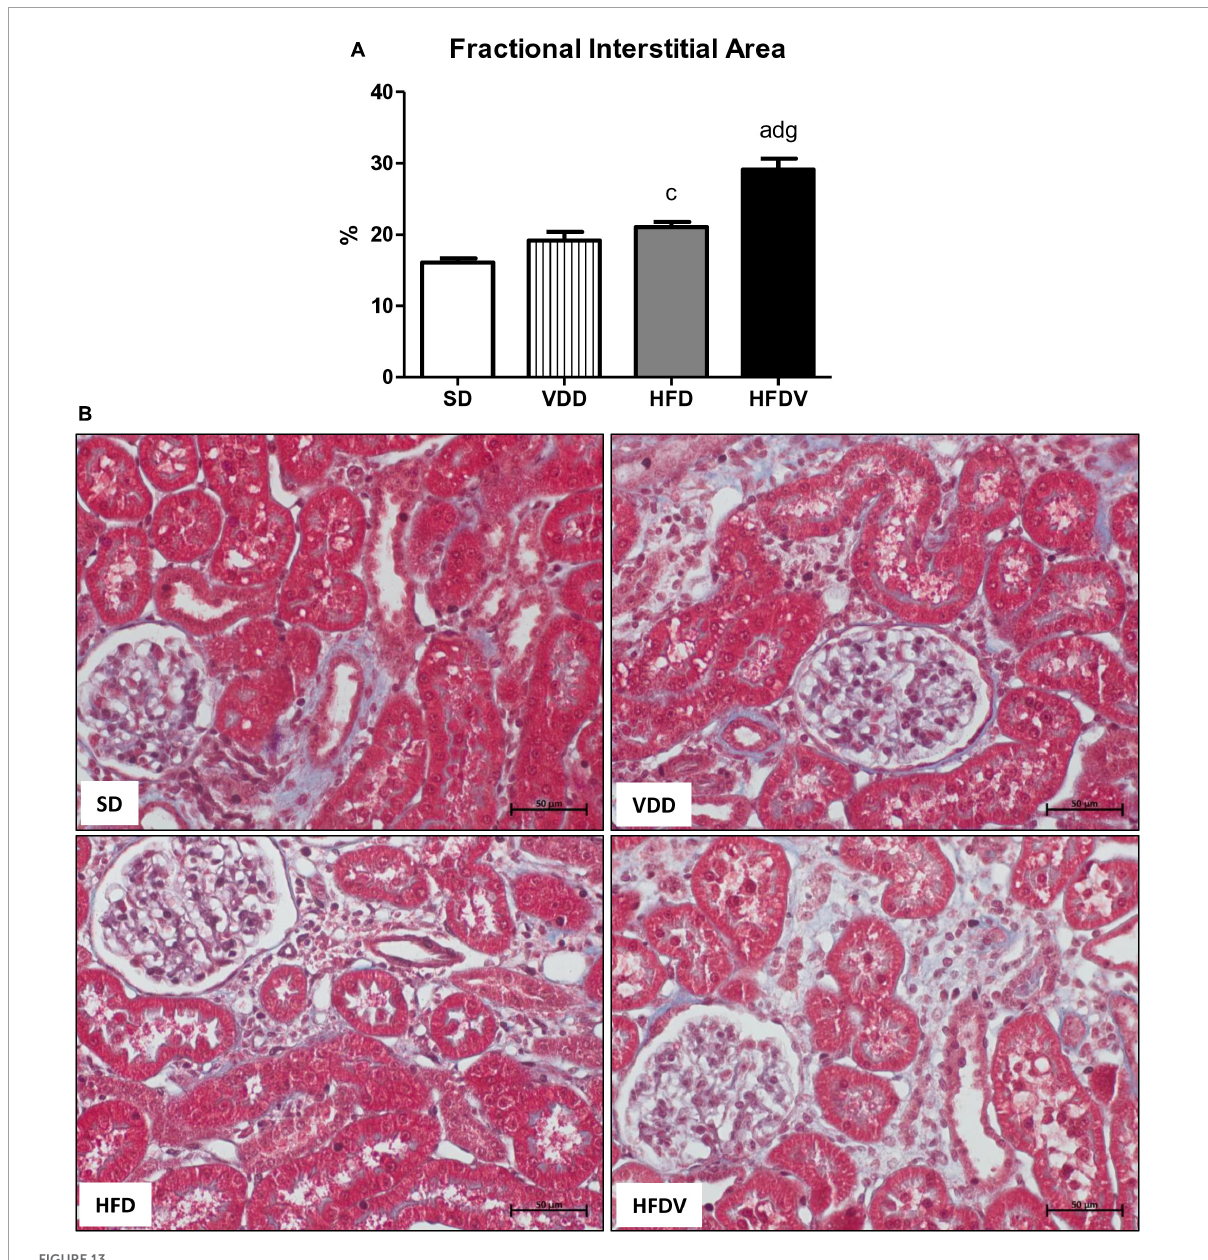
FIGURE13 Fractional interstitial area (FIA) of the renal cortex evaluated after the 90-day protocol in rats submitted to renal ischemia-reperfusion insult on day 45 treated with standard diet (SD), vitamin D-free diet (VDD), high-fat diet (HFD) or high-fat vitamin D-free diet (HFDV). (A) Bar graph of FIA values. (B) Masson’s trichrome representative photomicrographs of renal histological changes from an SD, VDD, HFD, and HFDV rat ( × 400). Data are mean ± SEM. a p < 0.001 and c p < 0.05 vs. SD; d p < 0.001 vs. VDD; g p < 0.001 vs.